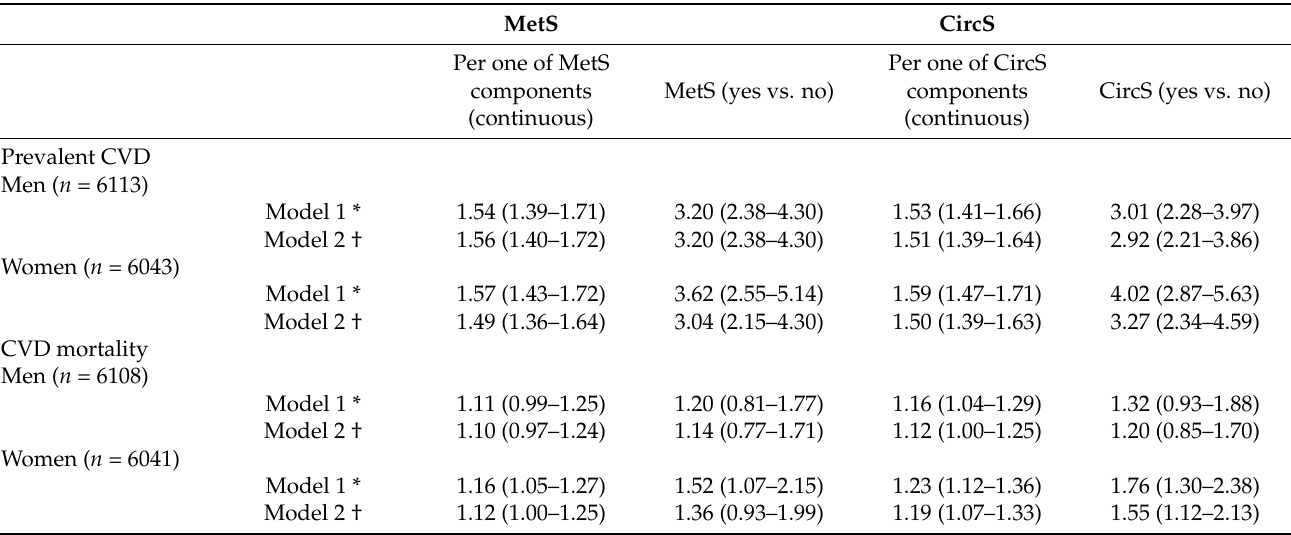
Values are odds ratio (95%CI) derived from multivariable logistic regression models for prevalent CVD and hazard ratio (95%CI) from Cox regression for CVD mortality. * Model 1 adjusted for age. † Model 2 further adjusted for education, race, physical activity, smoking (never, former, current), and alcohol drinking (no, yes, missing). Abbreviations: CircS, circadian syndrome; MetS, metabolic syndrome; CI, confidence